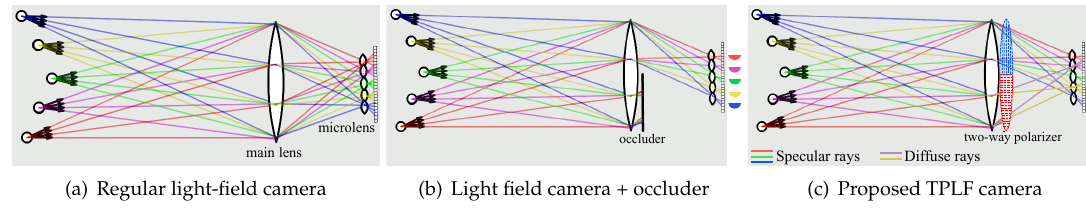
Figure 1. Ray simulation (based on Andrew Adams’s optical bench toolkit (http://graphics.stanford. edu/~abadams/lenstoy.swf)) for illustrating the concept of the proposed TPLF camera. ( a ) Regular